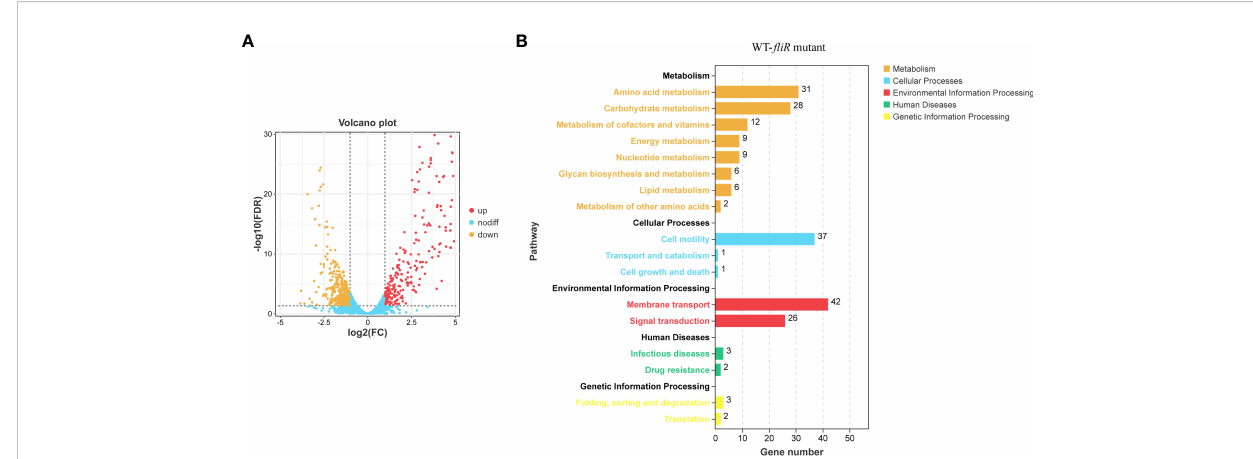
FIGURE 3 Comparison of the transcriptomes of fl iR mutant strains and wild-type strains. The transcriptomes of the wild and mutant strains identi fi ed the number of differentially expressed genes, with 280 up-regulated genes and 398 down-regulated genes in the mutant strains (A) . The Kyoto Encyclopedia of Genes and Genomes (KEGG) enrichment analysis shows that mutations in fl iR mainly affect pathways related to carbohydrate metabolism, amino acid metabolism, cell motility, membrane transport, and signal transduction (B)